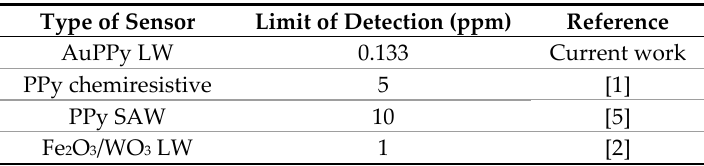
Table 1. The limit of detection for various sensors towards NH 3